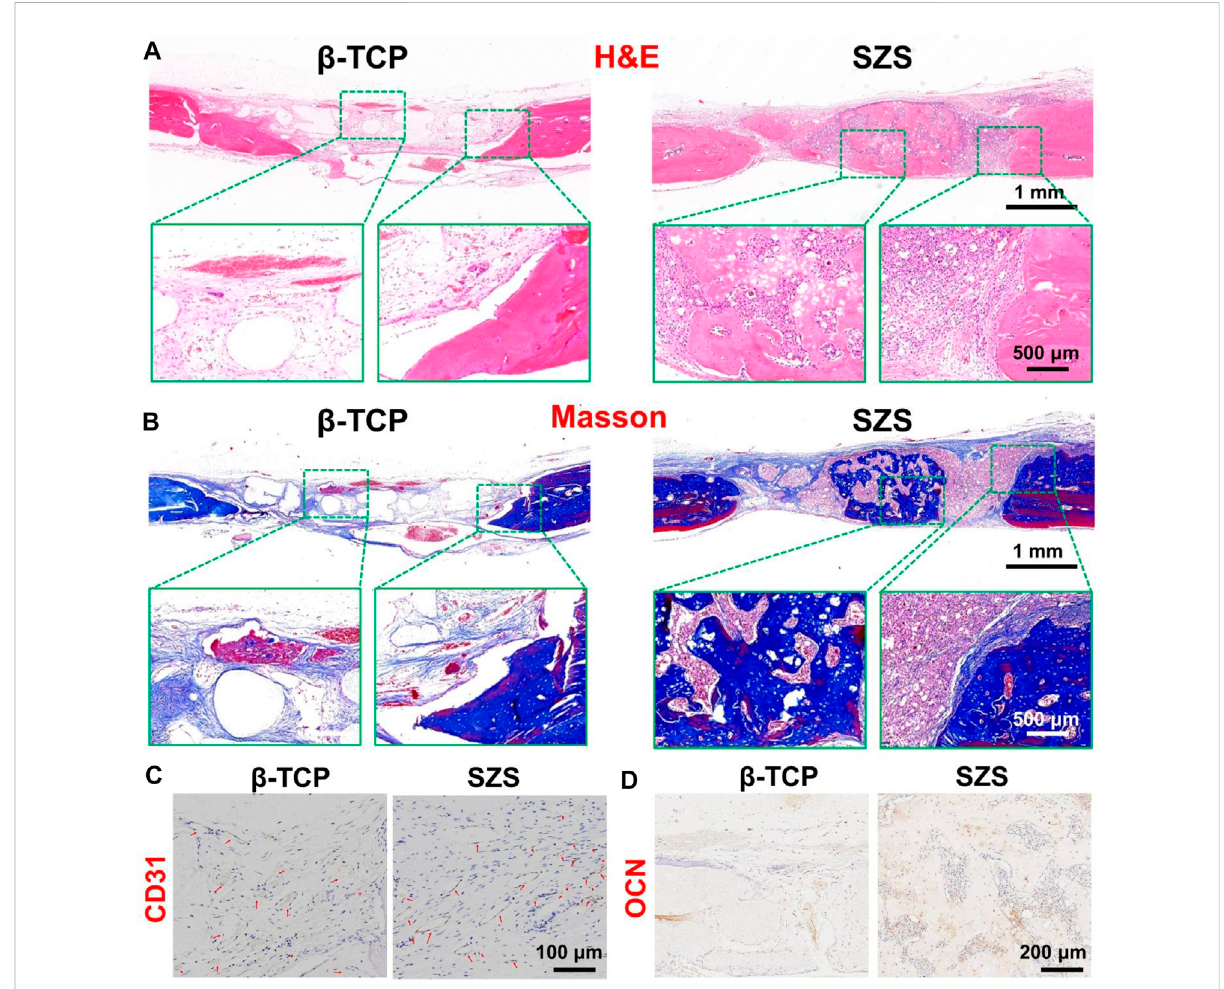
FIGURE 7 Representative H&E staining (A) and Masson ’ s trichrome staining (B) of the craniums with cranial defects after implantation of 3D printed SZS and β -TCP scaffolds for 2 months. Representative immunohistochemistry staining images targeting angiogenic marker CD31 (C) and osteogenic marker OCN (D) in new-formed